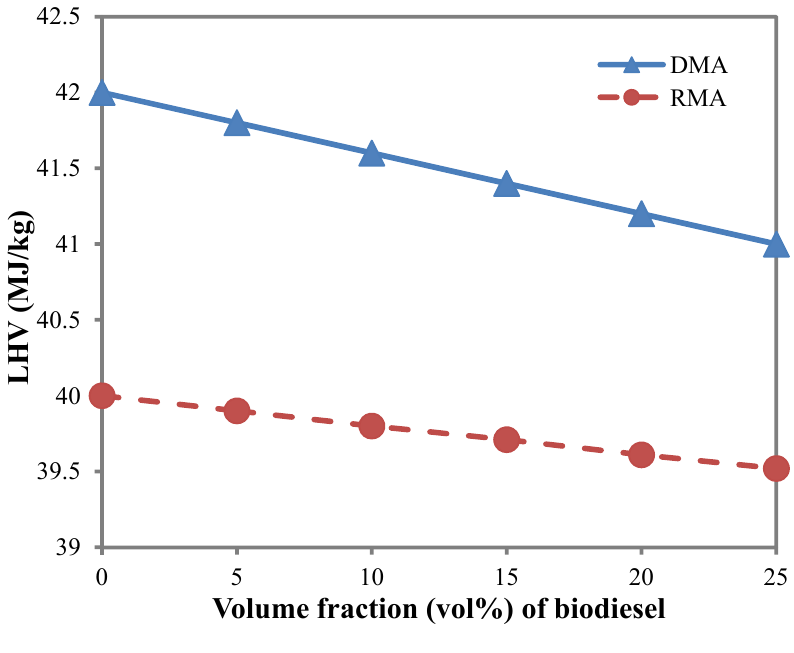
Figure 5. Variation of lower heating value (LHV) with volume fraction of biodiesel blends in distillate marine fuel DMA and residual marine fuel